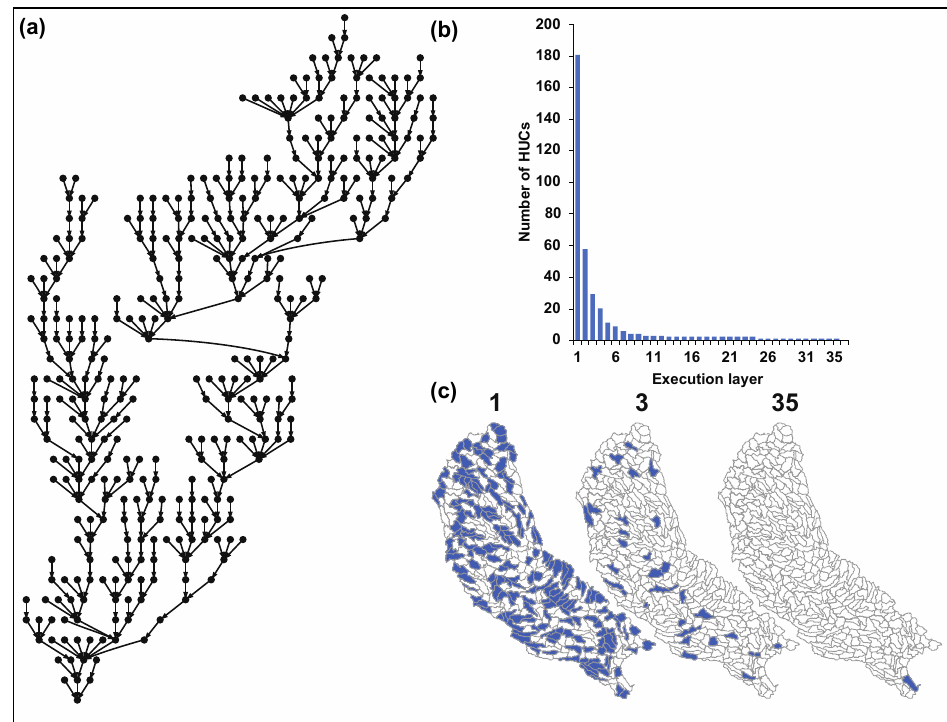
Figure 6. Graphical representation of the AnnAGNPS ITEAMS simulation execution sequence. Streamflow from one HUC12 to another determines the hierarchical execution sequence tree in which each dot represents an AnnAGNPS simulation at HUC12 scale ( a ). The execution tree is 35 layers deep indicating 35 sets of concurrent AnnAGNPS simulations ( b ). Lower execution layers are located throughout the basin while higher execution layers are located towards the main basin’s outlet ( c ). Table 1. Comparison metrics between single and integrated AnnAGNPS ITEAMS simulations at daily time scale of loads at the watershed outlet. Single simulation results were considered refer- ence.